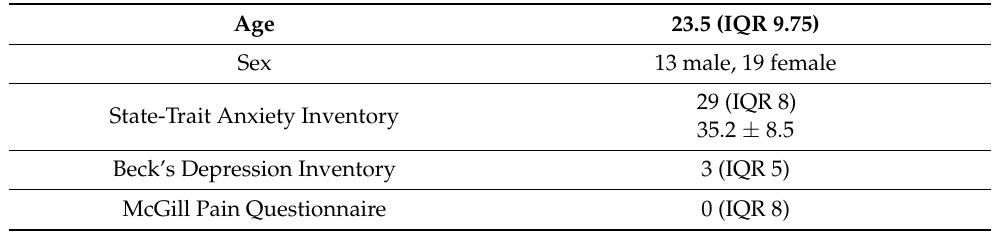
Table 1. Participant